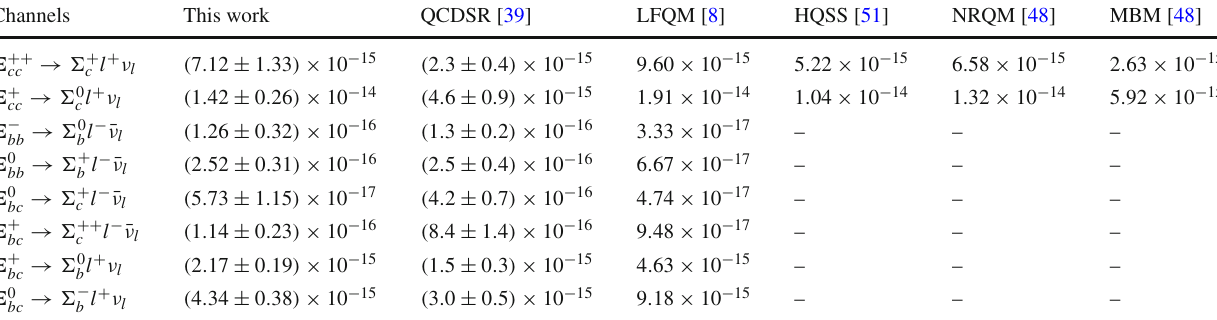
branching ratios could be tested by LHCb and other exper- iments in the future. Theoretically, we hope our calculation can help people to exam the singly heavy baryon LCDAs, and further improvement on these LCDAs as well as higher order corrections on this LCSR calculation are also expected in the